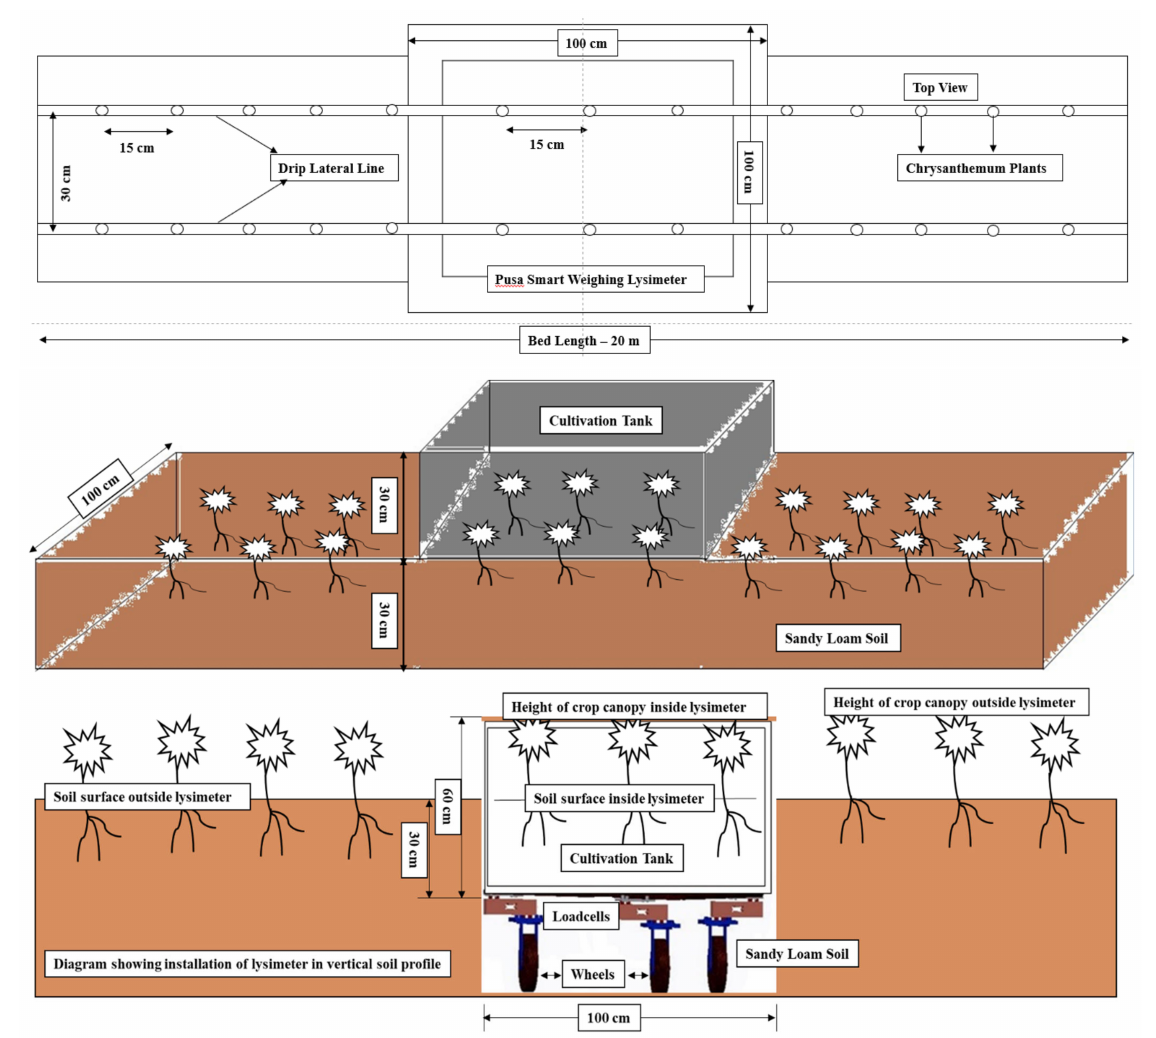
Figure 6. Schematic diagram of Lysimeter installed in the middle of the bed with proper management having a fixed plant-to-plant and row-to-row spacing.